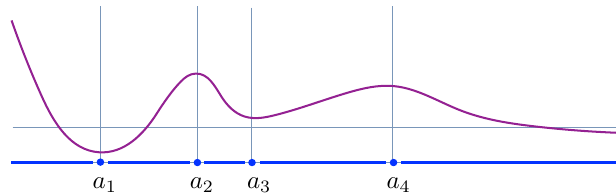
Figure 3 . Sketch of the graph of a definable function from R → R and the split of the domain into finitely many open